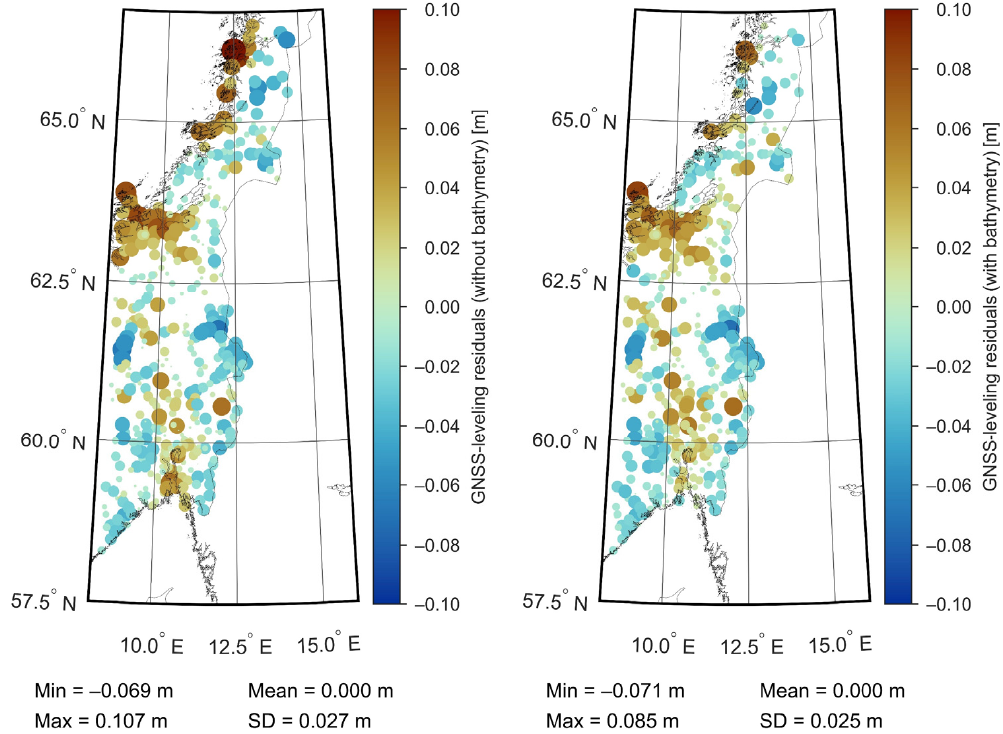
Figure 19. Residuals (mean removed) of gravimetric geoid models relative to the Norwegian GNSS- leveling control points. GGM: GOCO05c, modification limits: 200. The sizes of colored dots are proportional to the residual